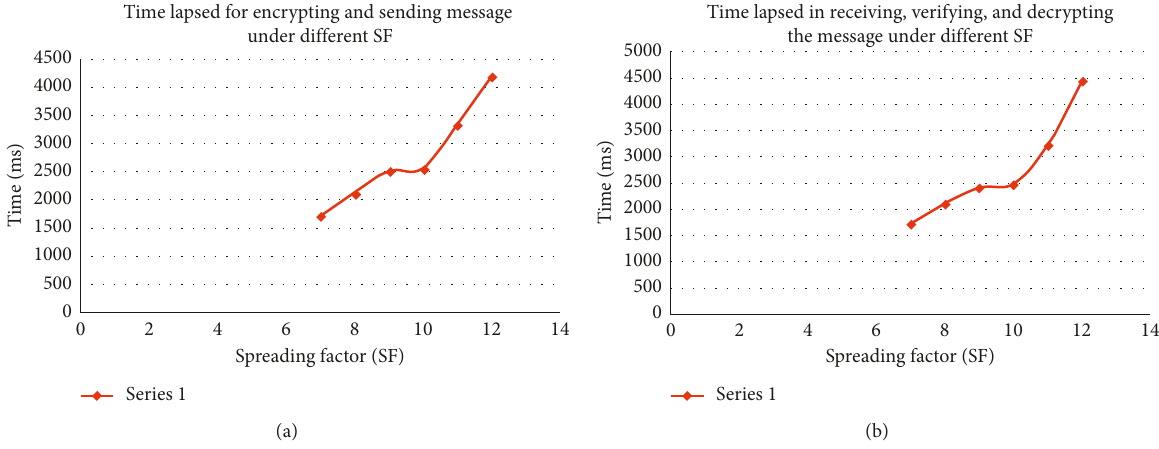
Figure 6: Latency for different SF and AES on the (a) sender end and (b) receiver end.